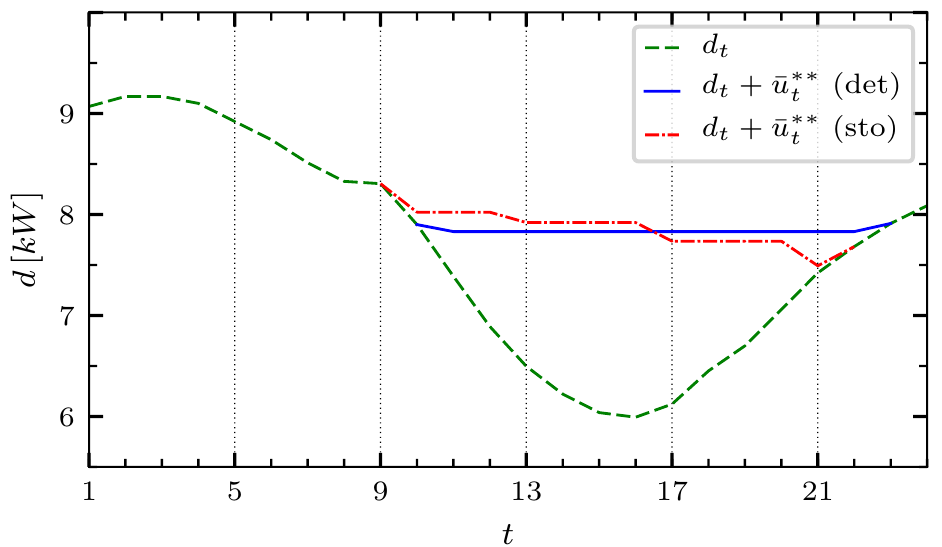
Figure 2. Two examples of aggregate control curve ¯ u ∗∗ t solving the social optimum condition. The green, dashed curve describes the non-PEV demand, and follows the non-PEV demand curve d ( 1 ) introduced in Section 7. The blue curve represents total demand in the deterministic case and is valley-filling. The red, dash-dotted curve is calculated in a stochastic framework with the S-adapted information structure. It represents the total demand for the scenario realization corresponding to the depicted non-PEV demand curve d t . Details about the numerical settings are discussed in Section 7. In particular, the stochastic curve is borrowed from the upper-left subplot in Figure